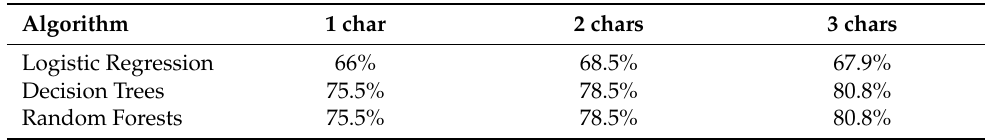
Table 2. Accuracy of gender prediction for different algorithms and features on the NLTK + SSA GOV